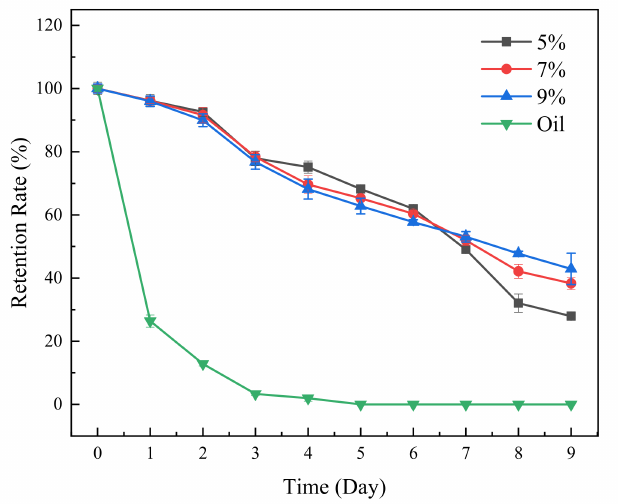
Figure 8. Light stabilities of β -carotene under UV irradiation in the oil and Pickering emulsion gels developed by sorghum flour at ϕ = 70% and c = 5, 7 and